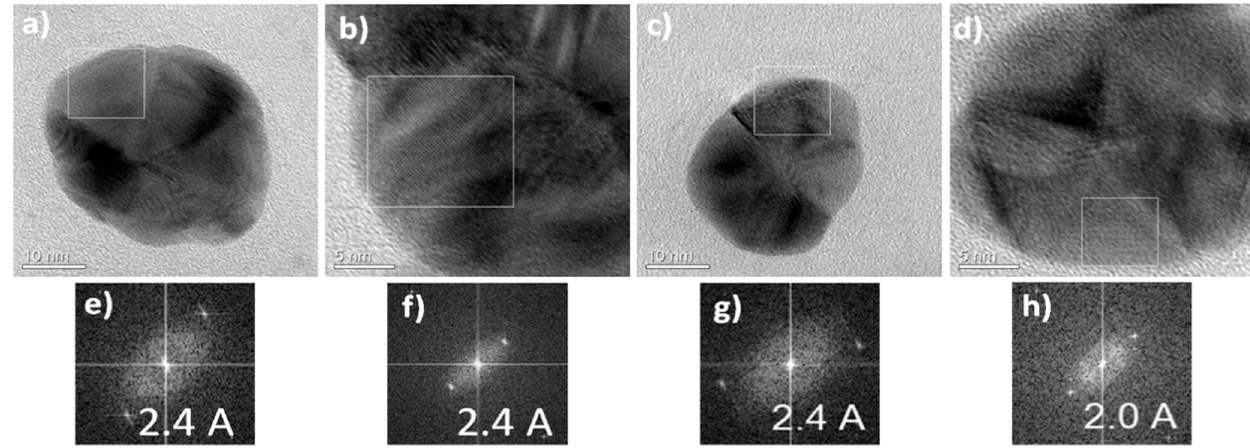
Figure 9. ( a – d ) High resolution transmission electron microscopy (HRTEM) images in different orientations of AgNPs from sample 16 and ( e – h ) the corresponding characteristic fast Fourier transformation FFTs. this figure shows clearly the crystalline nature of AgNPs through the fully isolated solo lattice fringes (the spacing of 2.4 Å is compatible with the lattice spacing of plane (1 1 1) of pure silver and spacing of 2 Å is compatible with the lattice spacing of plane (2 0 0) of pure silver).